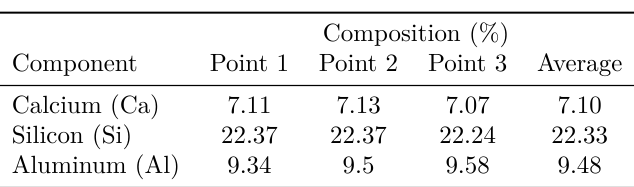
Table 1. XRF Result of Coal Fly Ash.